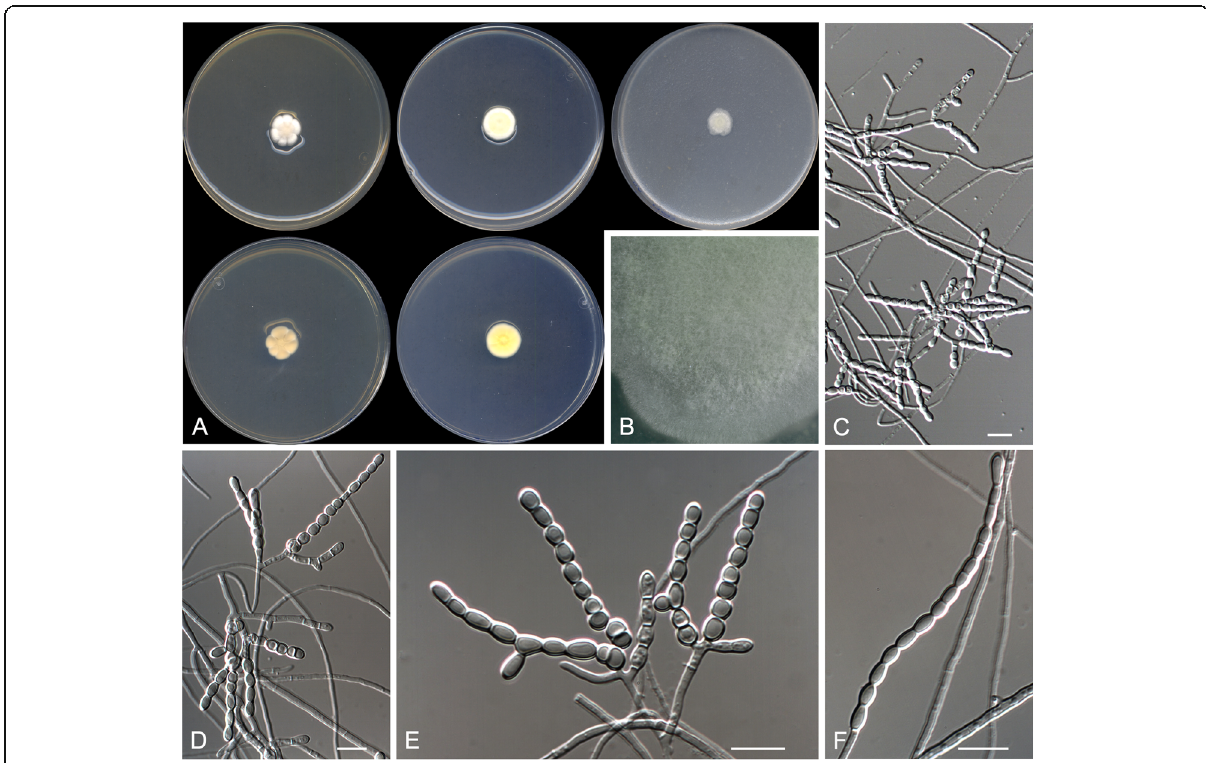
Fig. 9 Pseudoarthropsis crassispora CBS 146928 T . a Colonies on PYE, PDA and OA after 14 d at 25 °C, from left to right (top row, surface; bottom row, reverse). b Detail of the colony on OA. c – e Bi- to trichotomously-branched fertile hyphae. f A large chain of holoarthric conidia. Scale bar = 10 μ